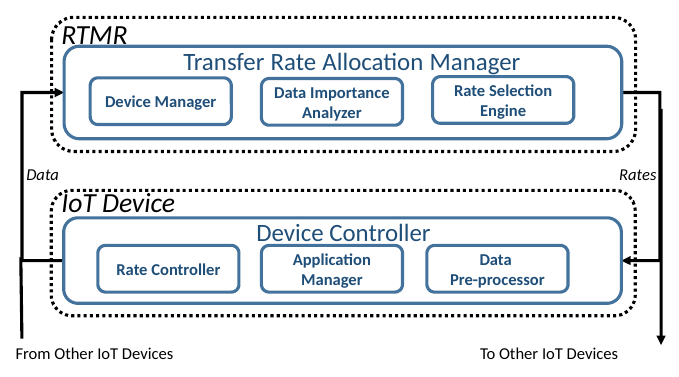
Figure 3. RTMR Front-End: Data and Rate Control Message Flows for Transfer Rate Adaptation Based on Data